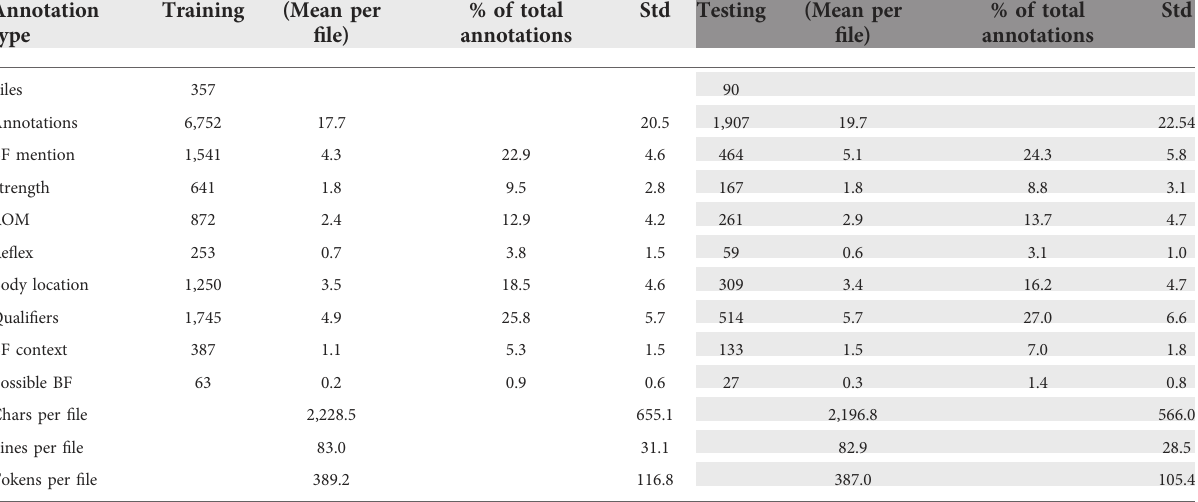
TABLE 2 Distribution of manual annotations in SSA